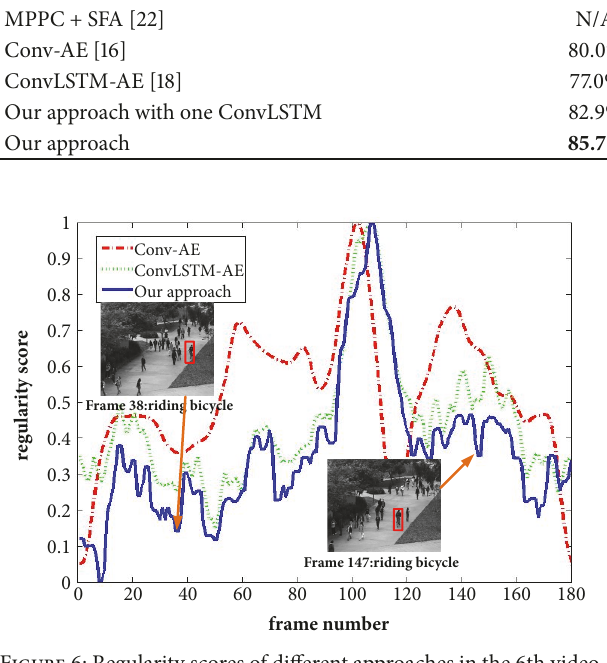
Figure 6: Regularity scores of different approaches in the 6th video clip of Avenue dataset.